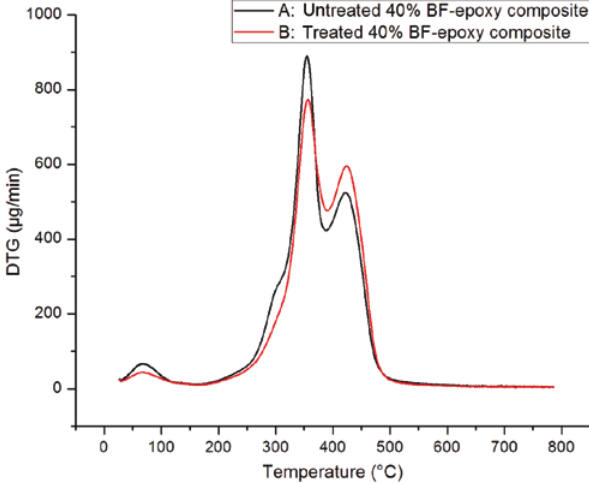
Figure 10: DTG thermogram of untreated and treated 40% BF-epoxy composites.